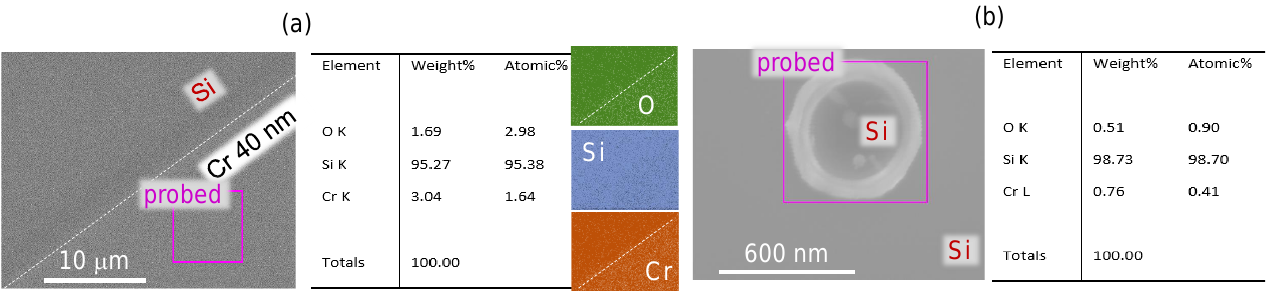
Figure 6. X-ray energy-dispersive spectroscopy (EDS) area scan for chemical composition of O, Si, Cr. ( a ) A film of 40 nm Cr was coated on Si substrate before laser exposure. Edge between Si and Cr coating was determined by a cover glass rim during e-beam evaporation. ( b ) A Cr–Si alloyed ring at pulse energy of E p = 1.1 ± 0.1 nJ (on sample); λ = 515 nm wavelength, objective lens of NA = 0.9. Cr was washed out after the laser exposure by Cr-etch; surface around the ring is